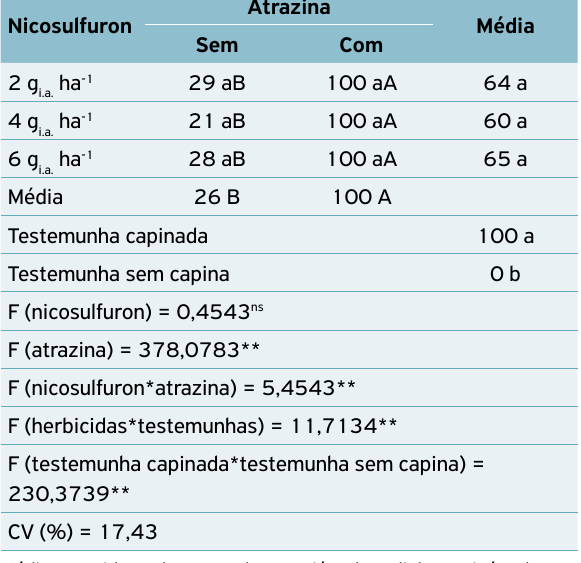
Tabela 1. Controle percentual de plantas de soja 30 dias após a aplicação de atrazina com diferentes doses de nicosulfuron na cultura do milho safrinha consorciado com Brachiaria ruziziensis . Maracaju, Mato Grosso do Sul,